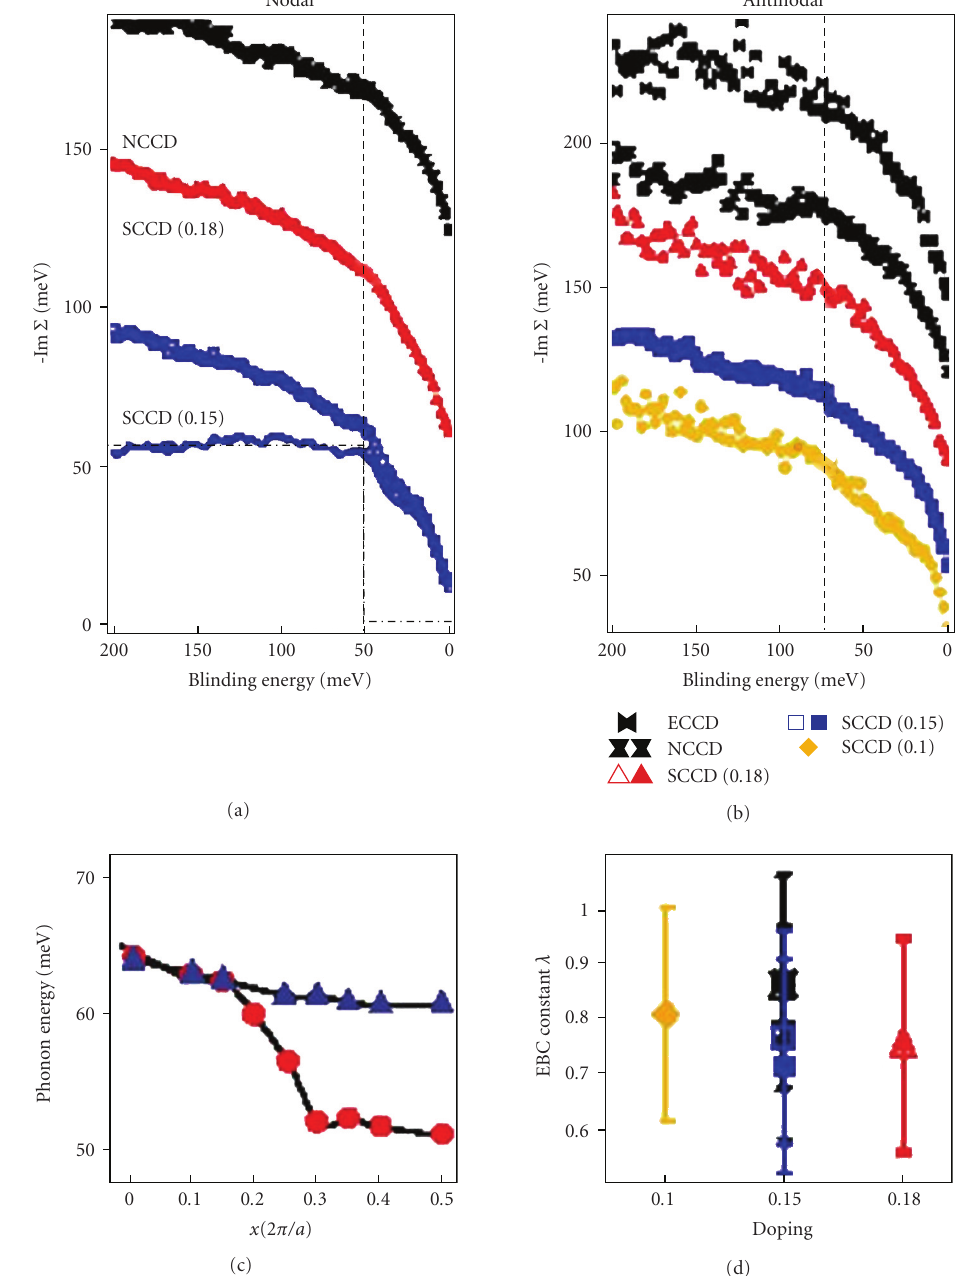
Figure 18: NCCO electron-doped: (a) Im Σ ( ω ) measured in the nodal point. Curves are o ff sets by 50 meV for clarity. The change of the slope in the last bottom curve is at the phonon energy. (b) Im Σ ( ω ) for the antinodal direction with 30meV o ff set. (c) Experimental phonon from Im Σ ( ω ). From dispersion of the bond stretching modes. (d) Estimated λ ep e ff